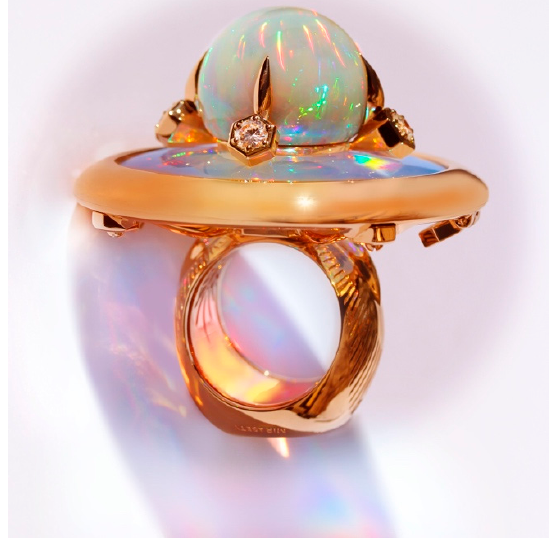
Figure 3. Couture 18K gold ring set with diamonds, opal, and a dichromated gelatin reflection hologram encapsulated in fused silica. Created by Mirasety, a collaboration of Francesco Mazzero, Michael Crawford, and August Muth. (Courtesy Mirasety, photo by Francesco Mazzero.)